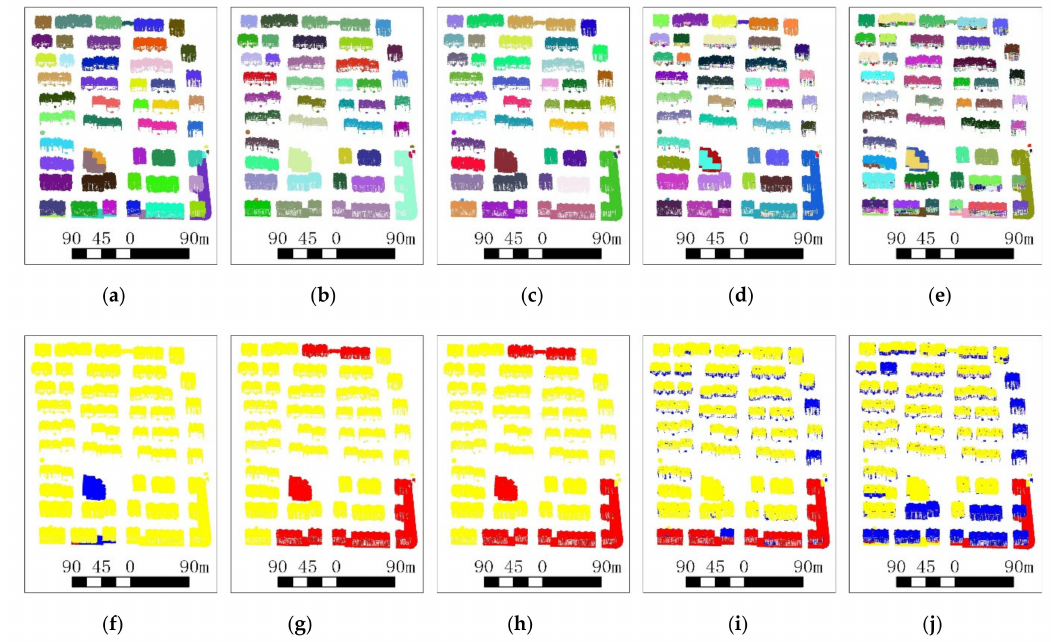
Figure 14. Building instance segmentation result comparison of dataset 2: ( a ) Result of the UBIS method; ( b ) result of the MV method; ( c ) result of the ES2D method; ( d ) result of the ES3D method; ( e ) result of the LCCP method; ( f ) the main differences between the result of the UBIS method and the ground truth; ( g ) the main differences between the result of the MV method and the ground truth; ( h ) the main differences between the result of the ES2D method and the ground truth; ( i ) the main differences between the result of the ES3D method and the ground truth; ( j ) the main differences between the result of the LCCP method and the ground truth.